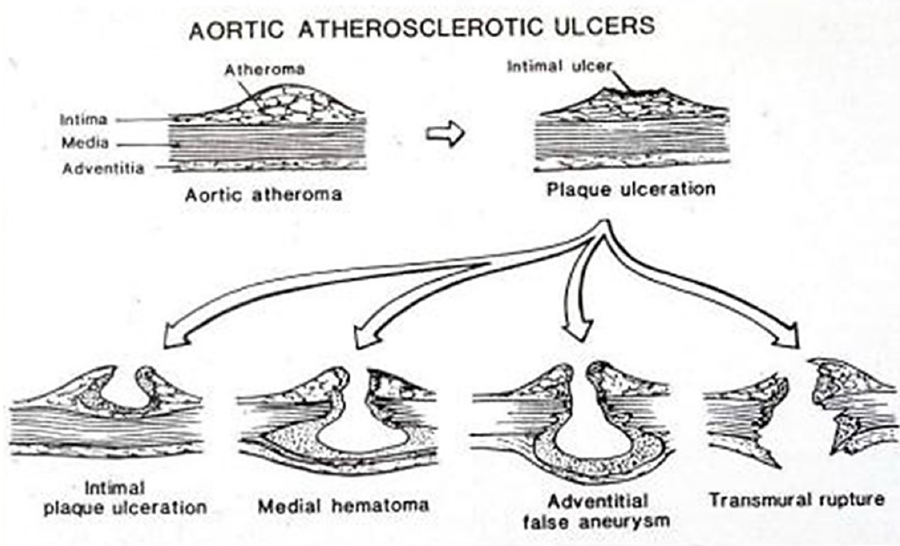
Figure 13. Ulcer of atherosclerotic plaque with intramural hematoma, false aneurysm and external rupture. Atherosclerotic aneurysm is the complication of progressive thinning of the tunica media due to the release of proteases (elastase included) by monocytes, which play a piv- otal role in the onset and progression of atherosclerosis [26]. Release of proteases in the intima may lead to thinning and rupture of the fibrous cap with thrombus deposition. On the outer side of the media, the release accounts for progressive thinning of the aortic wall